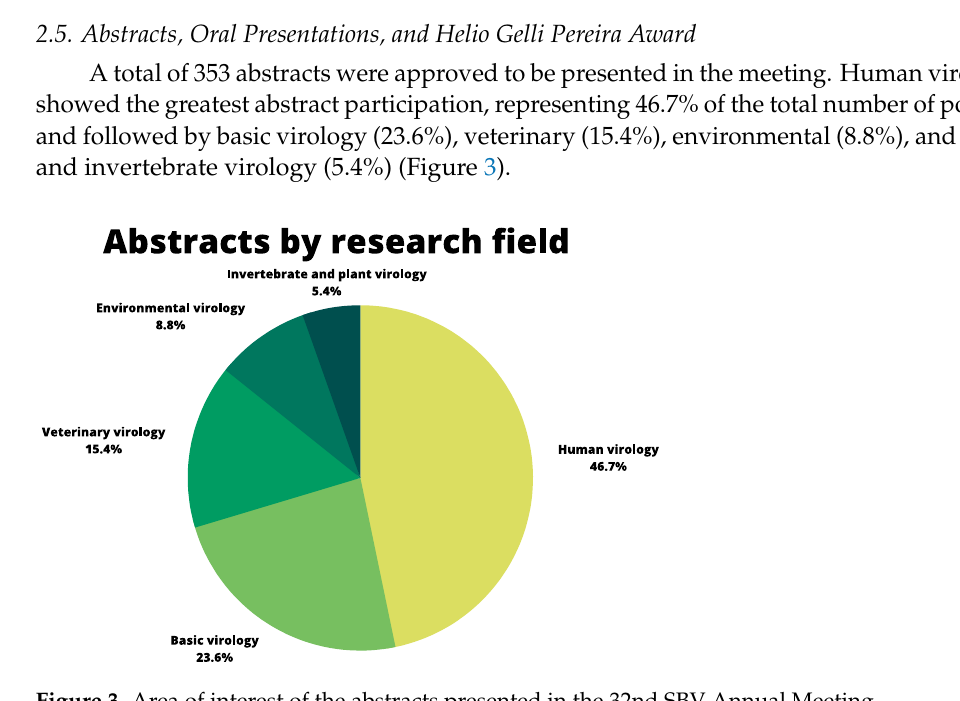
Figure 3. Area of interest of the abstracts presented in the 32nd SBV Annual Meeting.